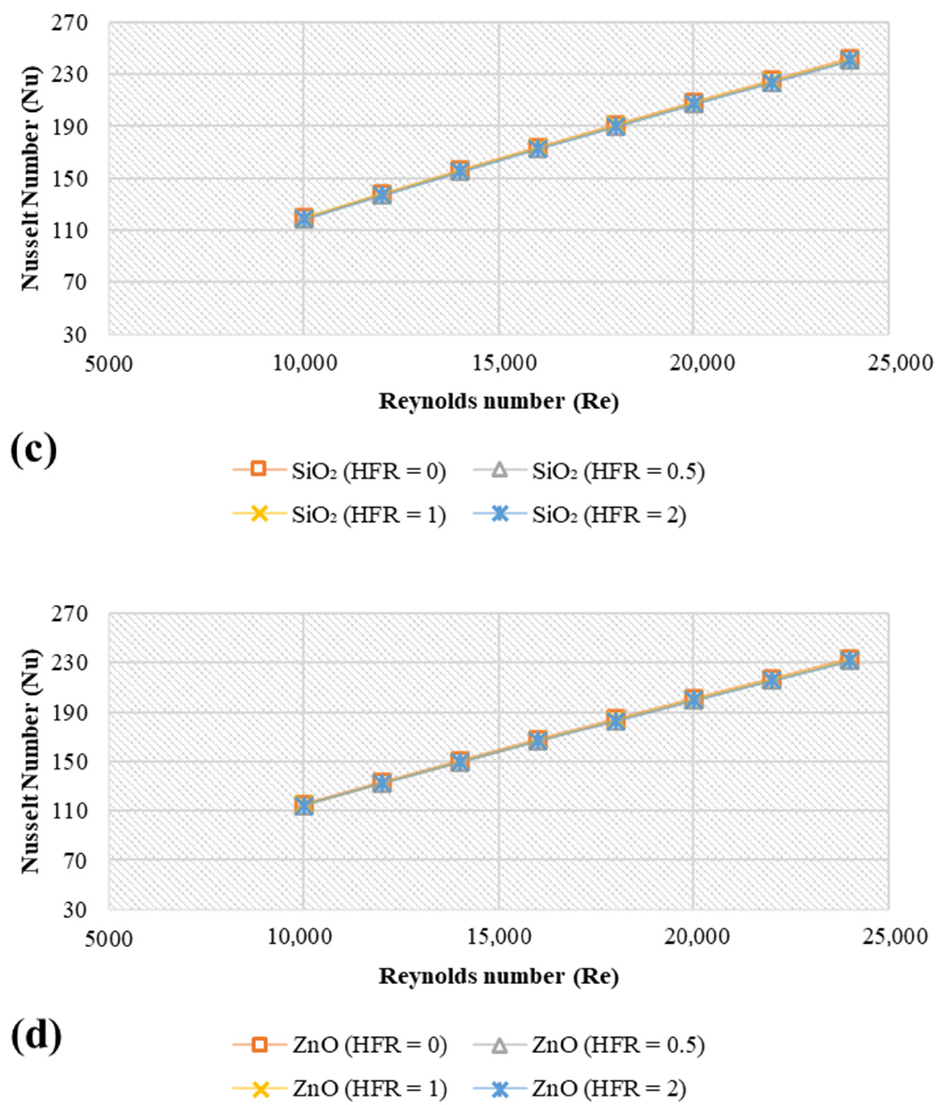
Figure 7. Simulation data of average Nusselt number for different metal oxides and different heat flux ratios at 4 vol.%, 20 nm, and 293 K; ( a ) Nanoplatelets -Al 2 O 3 , ( b ) Nanoplatelets -CuO, ( c ) Nanoplatelets -SiO 2 , ( d ) Nanoplatelets